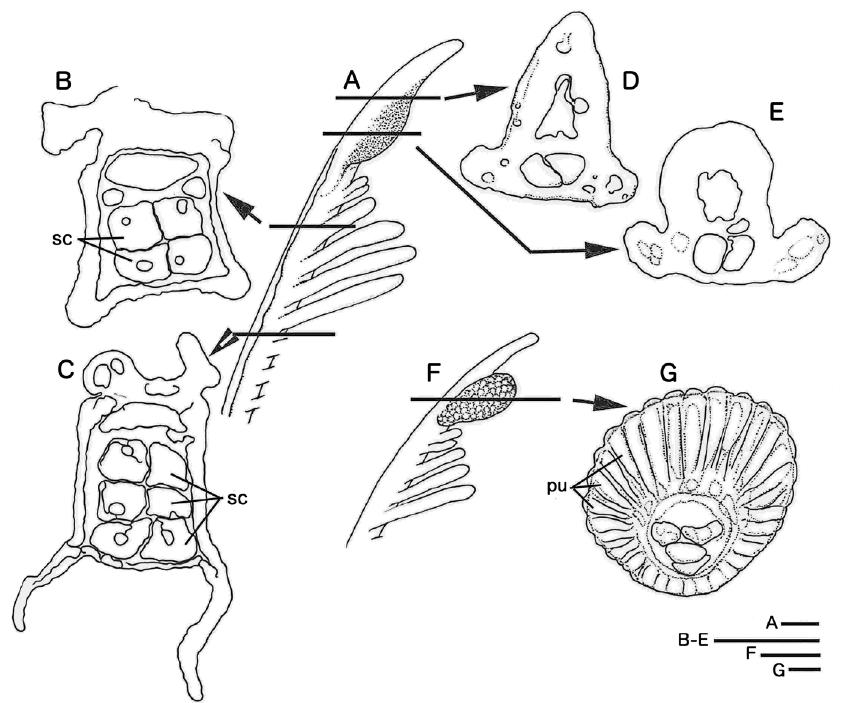
Figure 5. Notaulax yamasui sp. n. ( A–E ) and Megalomma sp. ( F, G ), internal structure of radiole. Notaulax yamasui sp. n. A radiole tip, lateral view B, C internal structure of proximal region of radiole D, E , internal structure of sub-distal swelling. Megalomma sp. F, G internal structure of compound eye F radiole with compound eye, lateral view G internal structure of compound eye, with many individual photoreceptor units (pu) B–E and G are drawn from sliced sections of eyes and radioles. Abbreviations: sc, skeletal cells; pu, photoreceptor unit. Scale bars 100µm ( A ), 200µm ( B–E ), 300µm ( F ), 20µm ( G